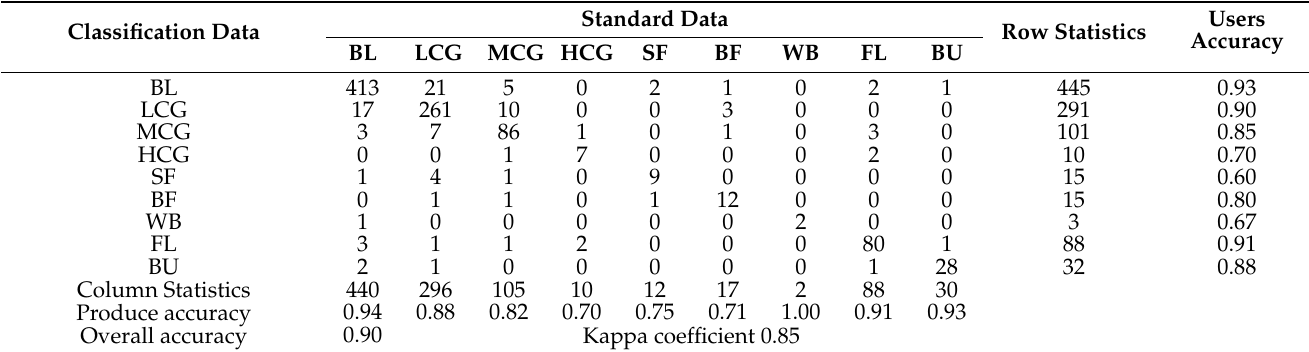
Table A3. Confusion matrix of land use mapping in Dunhuang oasis in